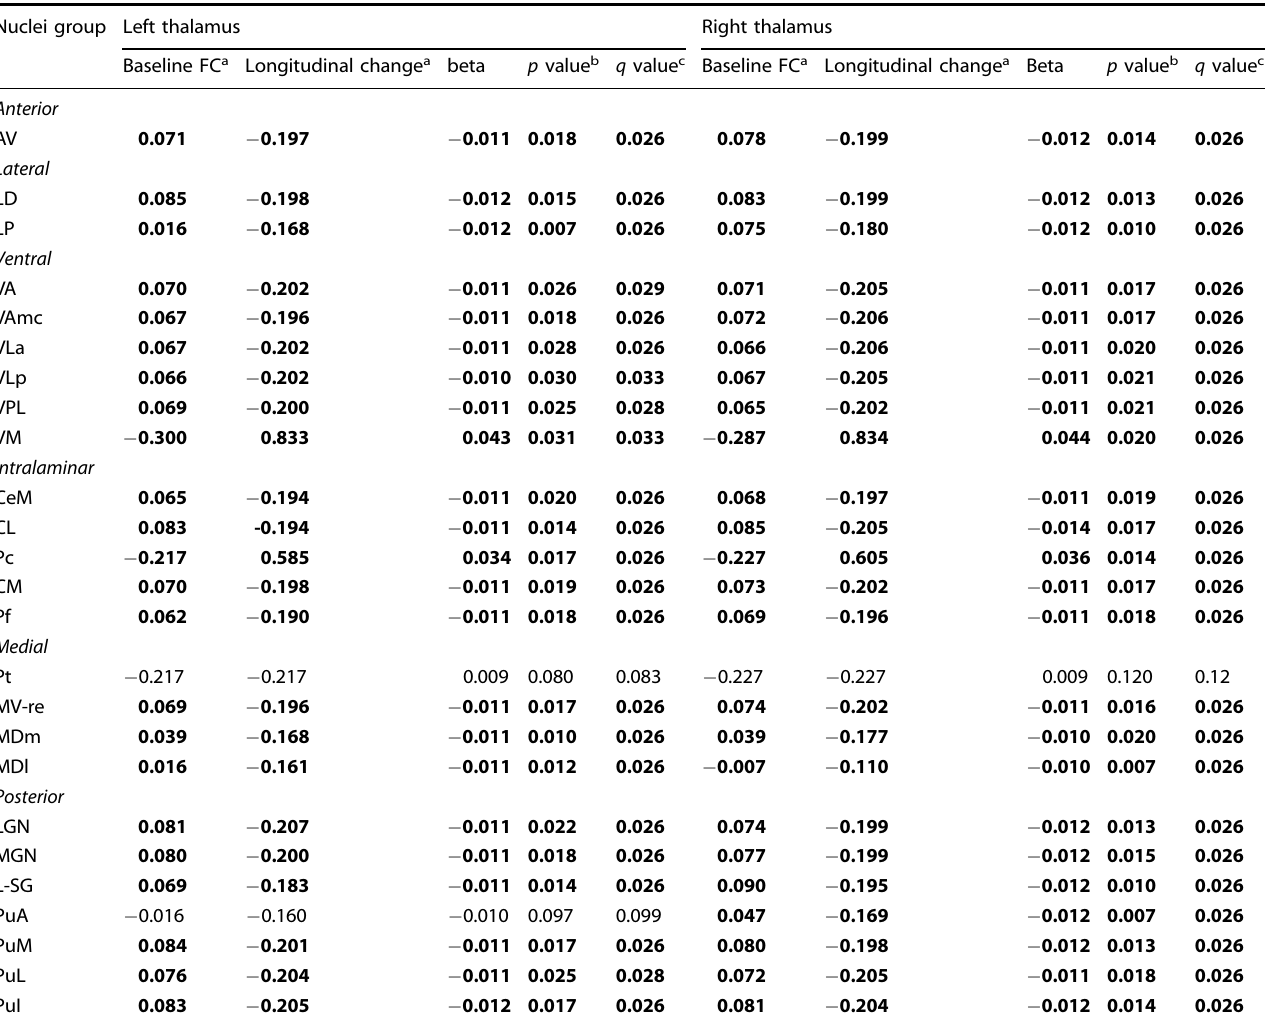
Table 4. Association of average HADS depression score with follow up thalamic subnuclei FC scores. Nuclei group Left